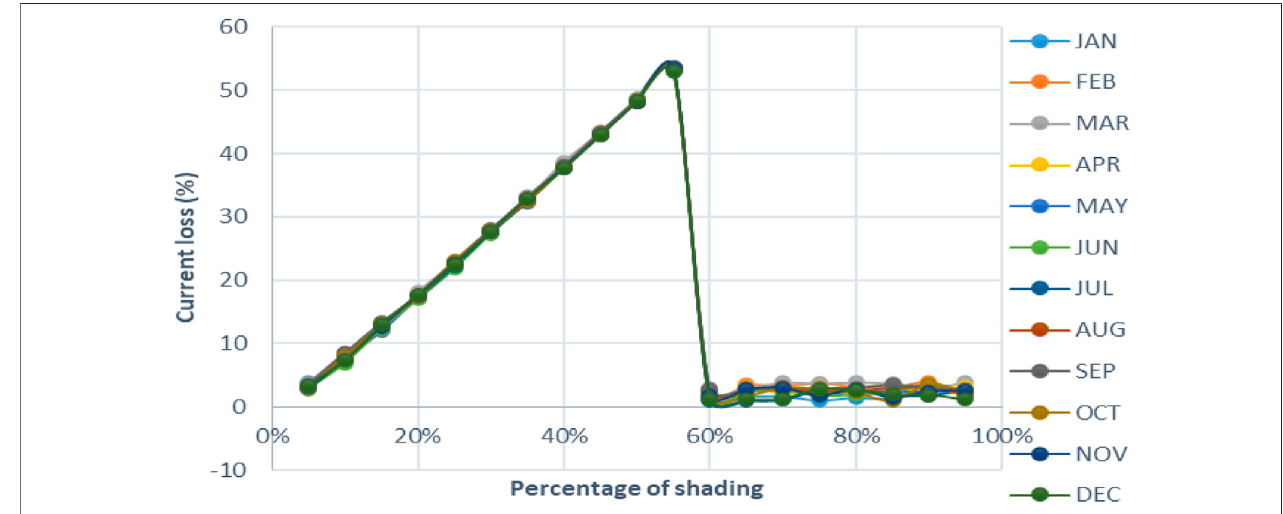
FIGURE 10 | Monthly current losses evolution.